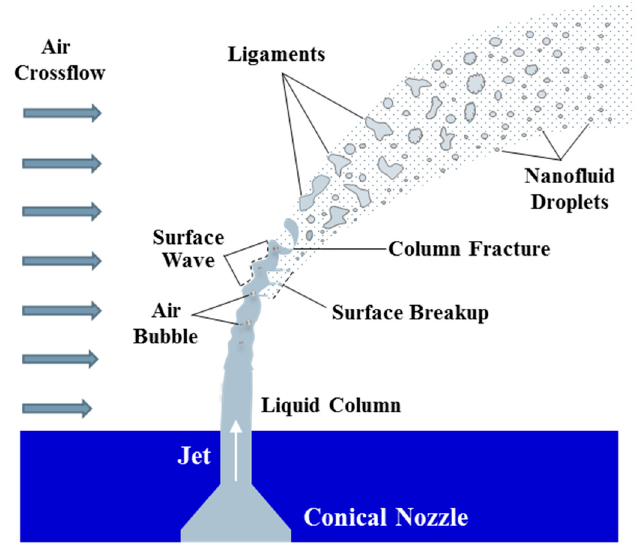
Figure 17. Primary breakup of nanofluids under transverse injection at a small We g .